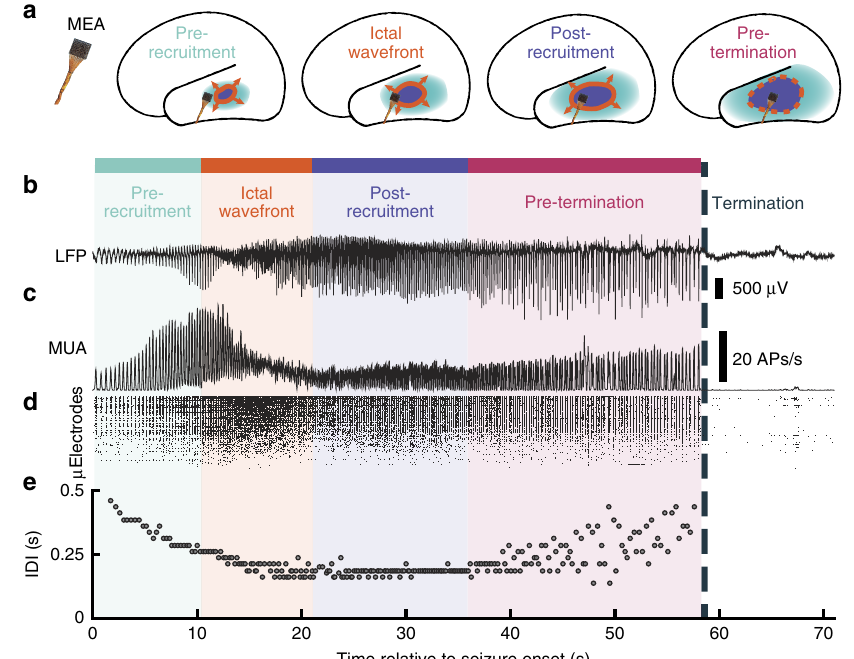
Figure 1 | Progression of seizure activity recorded from a microelectrode array in the ictal core. Colours indicate the different epochs in the seizure: light blue is the pre-recruitment epoch, orange is the ictal wavefront epoch, purple is the post-recruitment epoch and pink is the pre-termination epoch. Seizure termination is labelled with a dark blue dotted line. ( a ) Cartoon of hypothesized spatial organization of seizure activity relative to the microelectrode array (MEA) location. ( b ) Raw LFP traces recorded from a single microelectrode during a seizure. ( c ) Averaged firing rate over electrodes on the array during the seizure in b . ( d ) Multiunit raster plot over MEA channels during the seizure in b . ( e ) Inter-discharge intervals (IDIs) for each discharge through the duration of the same seizure. The abrupt transition from regular to irregular IDIs at 36s after seizure onset marks the transition from post-recruitment (period following passage of the ictal wavefront) to the pre-termination epoch. In both b and c , the abrupt cessation of discharges in both LFP and MUA, which is the defining event marking seizure termination, is